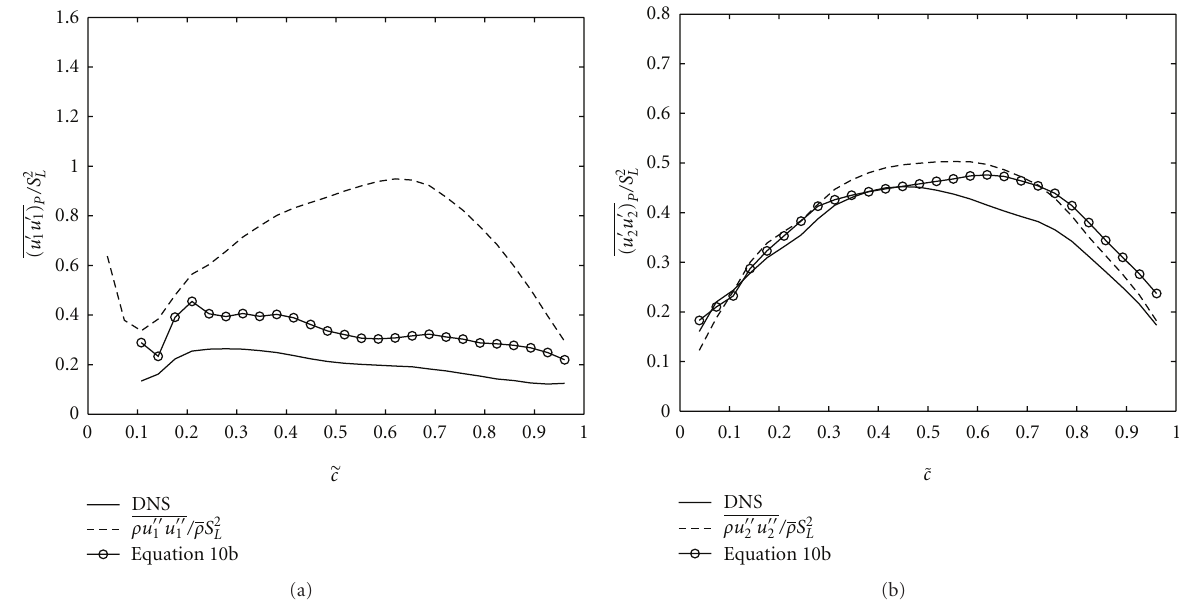
Figure 4: (a) Variations of ( u (cid:2) 1 u (cid:2) 1 ) and ρu (cid:2)(cid:2) 1 u (cid:2)(cid:2) 1 /ρS 2 with (cid:2) c across the flame brush along with the predictions of (10b). (b) Variations of /S 2 L L P ( u (cid:2) 2 u (cid:2) 2 ) and ρu (cid:2)(cid:2) 2 u (cid:2)(cid:2) 2 /ρS 2 with (cid:2) c across the flame brush along with the predictions of (10b). /S 2 L L P